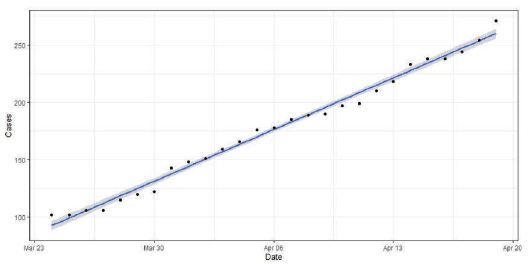
Figure 4: Total number of cases reported each day